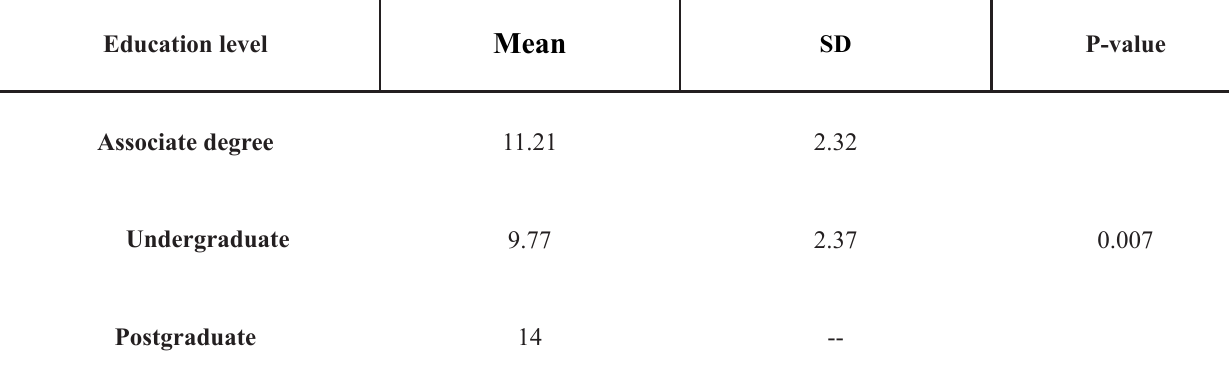
Table 3. Scores of knowledge of medical staff about the principles of radiation protection in terms of education